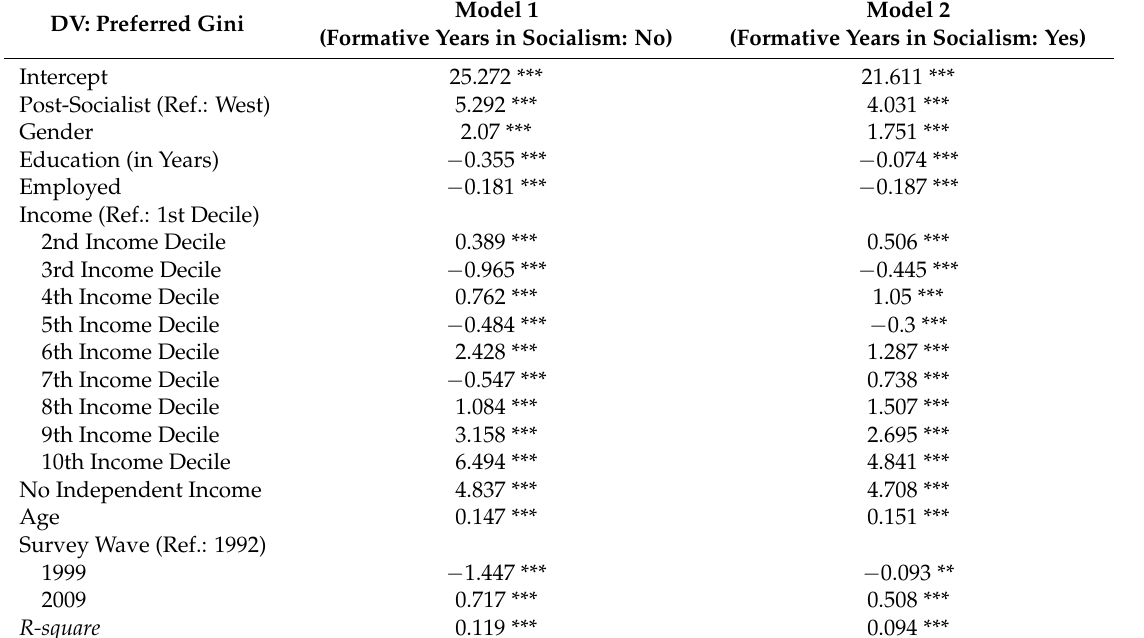
Table A7. Bootstrapped OLS regression models to explain the preferred Gini by formative years (corresponding with Figure 4a). DV: Preferred Gini